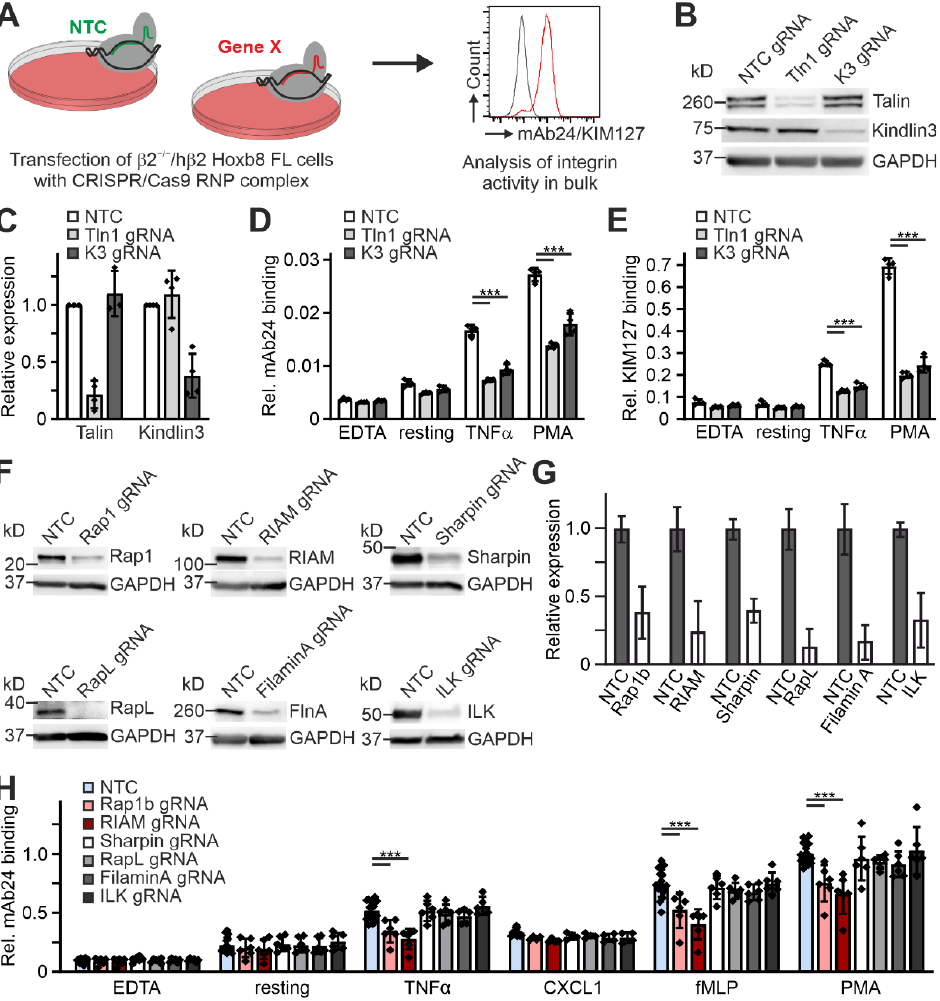
Figure 7. Rapid CRISPR-based screening approach to study putative β 2 integrin regulators. ( A ) Scheme of workflow. Integrin β2 −/− Hoxb8 cells expressing human integrin β2 were electrop orated